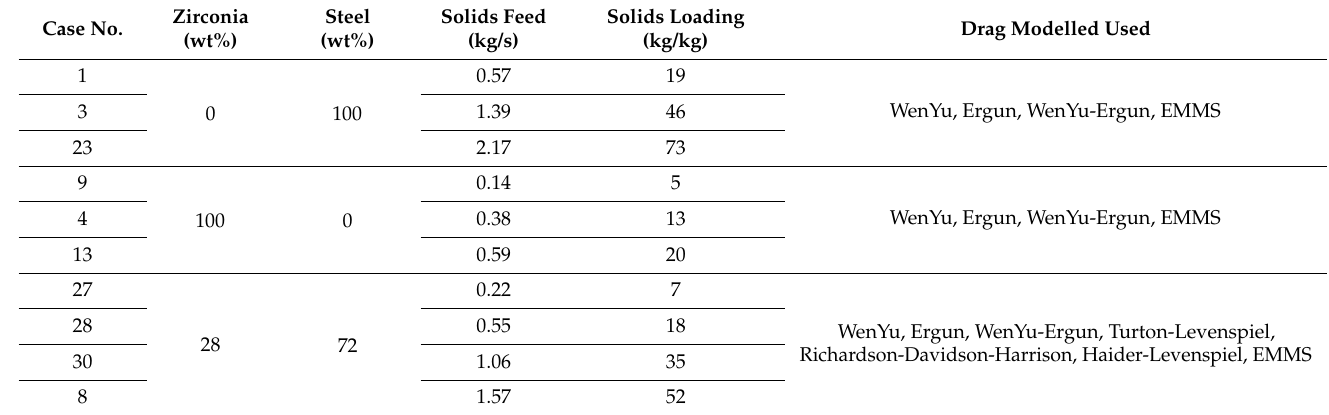
Table 4. Experimental and CFD simulated cases.